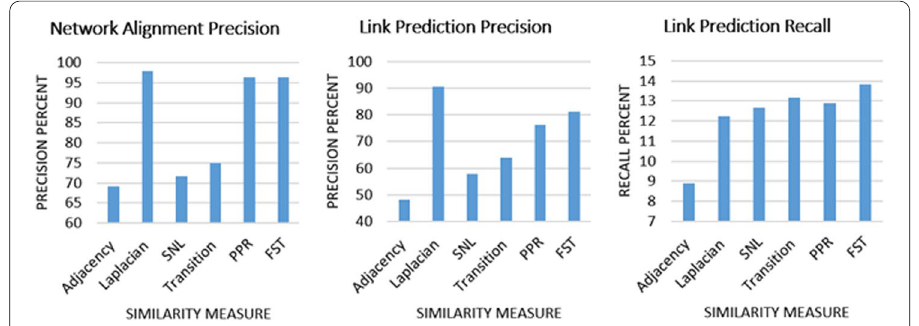
Fig. 7 Network alignment precision and link prediction precision and recall on Facebook/Twitter to compare similarity